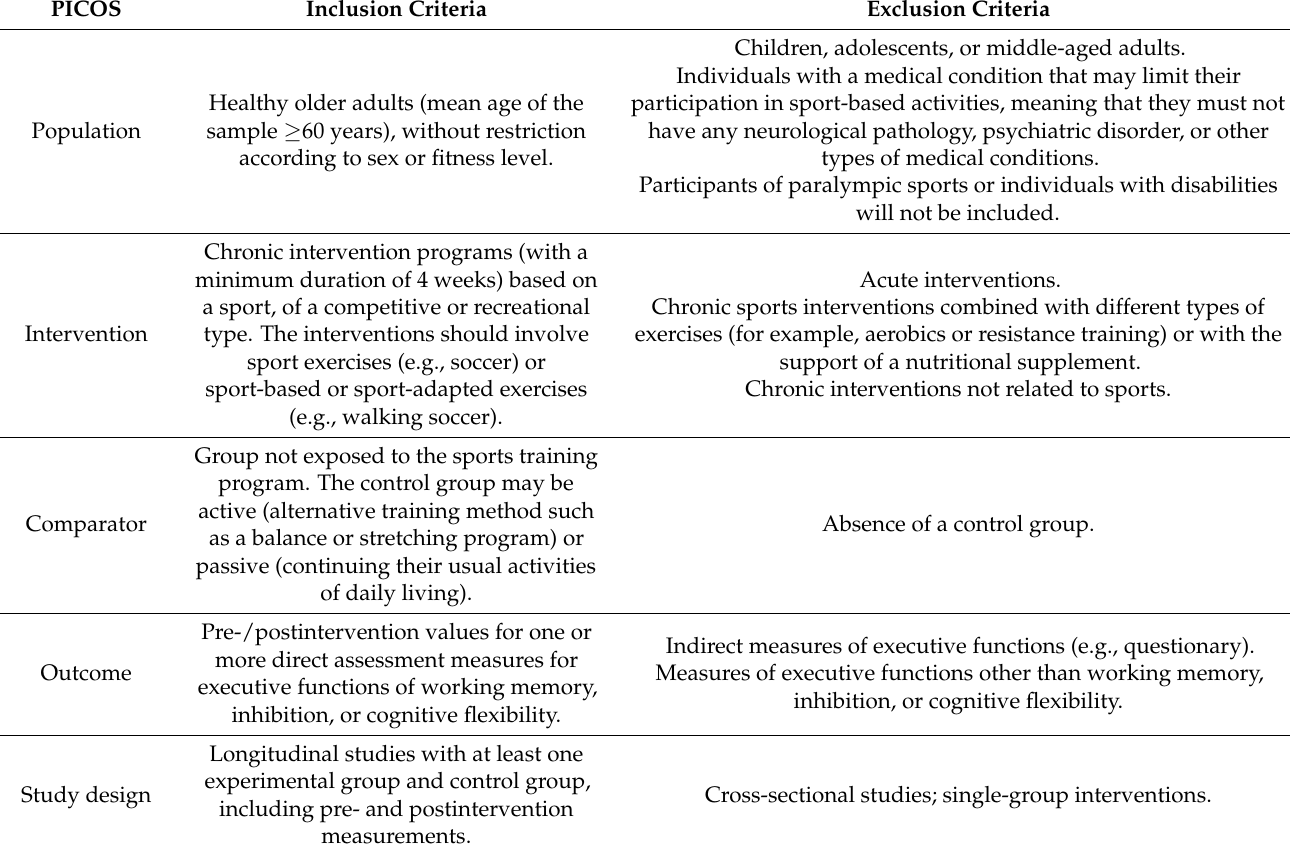
Table 1. Eligibility Criteria Based on